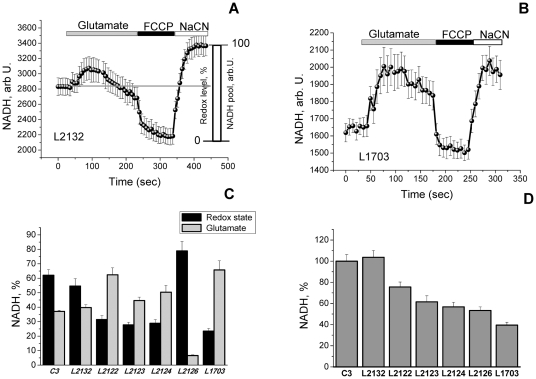
Redox state and NADH level in fibroblasts with PINK1 mutations and control cells.A–B Graphs demonstrate averaged trace of NADH autofluorescence in control L2132 fibroblasts (A) and L1703 PINK1 mutation (B). Estimation of the %age change in mitochondrial redox level in control cells – L2132 (A) and cells with mutations in PINK1 (B–C). C-Redox state was estimated as: 0 is response to FCCP (maximal rate of respiration and lowest level of mitochondrial NADH) and 100% is response to cyanide (inhibition of respiration with no consumption of NADH in mitochondria; Fibroblasts with PINK1 mutations have lower NADH redox state compared to control fibroblasts (except L2126) that can be normalized by application of 5 mM glutamate (C). D – Total pool of mitochondrial NADH was also significantly lower in fibroblasts with PINK1 mutations.